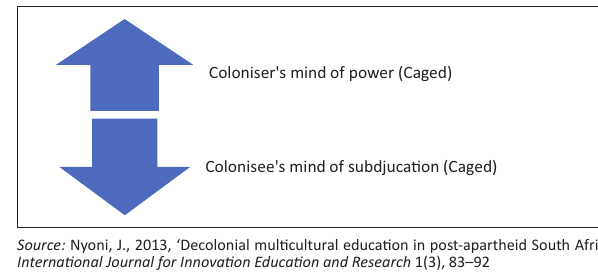
FIGURE 2: Two opposing ideological standpoints (minds) that diverge from a central